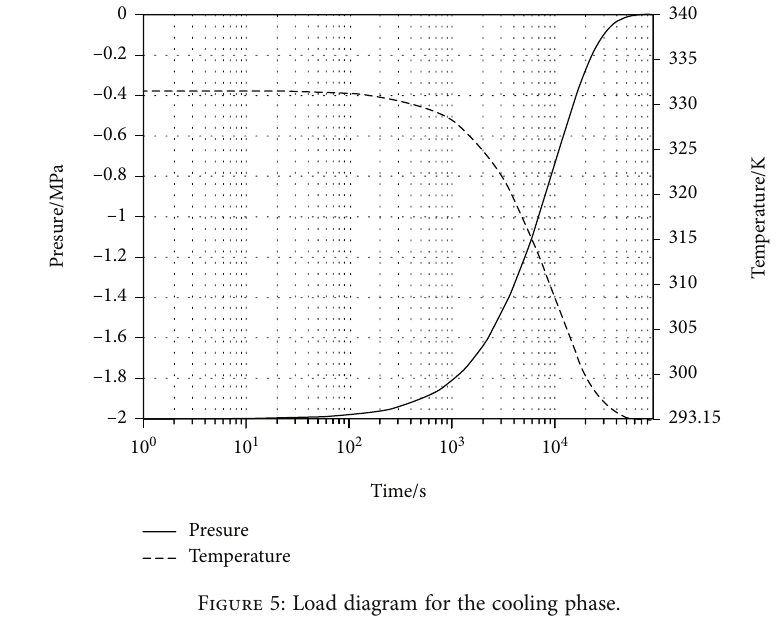
Figure 5: Load diagram for the cooling phase.